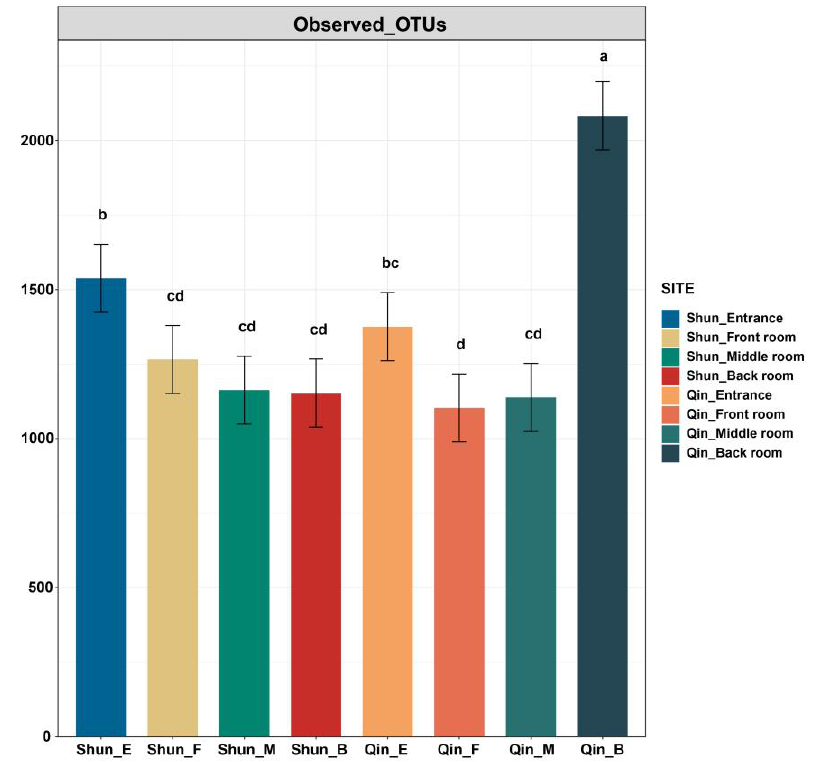
Figure 3. OTU richness among different positions of Shunling and Qinling Mausoleums. Different lowercase letters over error bars denote significant differences ( p < 0.05). Abbreviations: Shun_E, Shunling entrance; Shun_F, Shunling front room; Shun_M, Shunling middle room; Shun_B: Shunling back room; Qin_E, Qinling entrance; Qin_F, Qinling front room; Qin_M, Qinling middle room; Qin_B, Qinling back room.